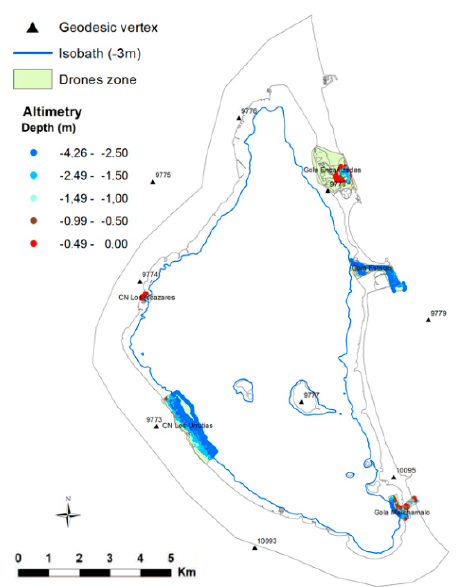
Figure 3. The five data collection areas where the Unmanned Surface Vehicle (USV) was used to provide data for calibrations of the algorithms designed to obtain bathymetries with Pleiades satellite images: CN Los Alcazares; CN Los Urrutias; Gola Marchamalo; Gola Estacio; and Gola Encañizadas.